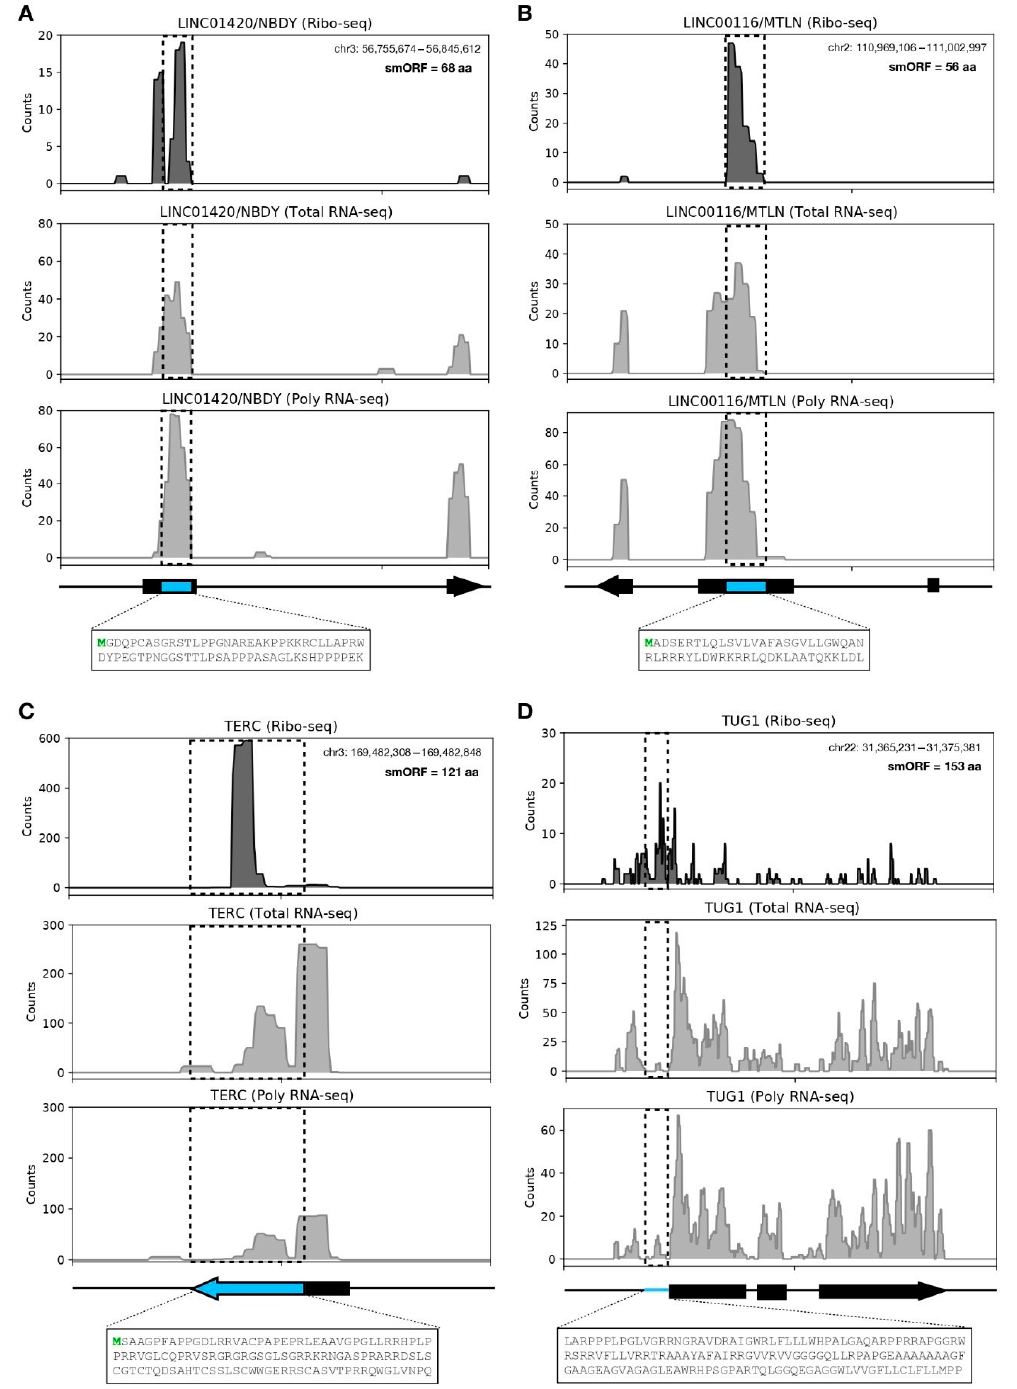
Figure 3. LncRNAs-encoded microproteins present in human adipose-derived stem cells. ( A ) Expression profile of microprotein NOBODY from LINC01420 with 68 aa. ( B ) Expression profile of microprotein MTLN from LINC0116 with 56 aa. ( C ) Expression profile of TERC with smORFs-encoded microprotein with 121 aa. ( D ) Expression profile of TUG1 with 5 (cid:48) UTR smORFs-encoded microprotein with 154 aa. Light blue boxes indicate the smORF location in transcripts, and the dashed boxes represent the smORF location in the read coverage plot. The upper panel represents Ribo-seq coverage, the middle panel represents Total fraction RNA-seq (Total RNA-seq) coverage, and the lower panel represents Polyso-mal fraction RNA-seq (Poly RNA-seq) coverage; the y-axis represents transcript raw